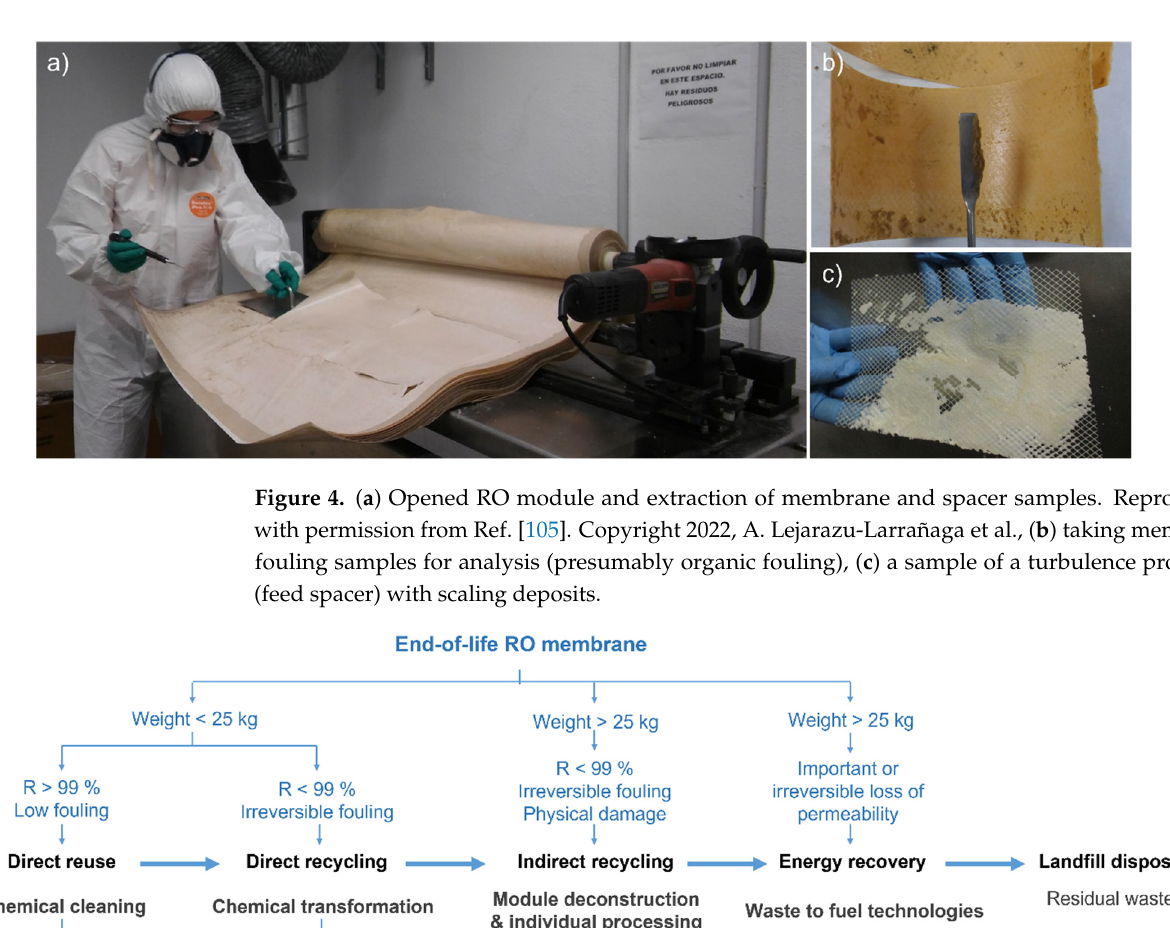
Figure 6. Schematic illustration of EoL RO membrane recovery for direct reuse as RO. PA, polyam- ide; PSF, polysulfone; PET, polyester. Those treatments resulted in some alteration of the RO salt rejection capacity ( R var- ied in the range between -29 % and 8 %), along with the enhancement of the membrane permeability (from ~3 L m − 2 h − 1 in new brand RO elements up to 261 L m − 2 h − 1 after the cleaning treatment). The reusability of RO membranes has been validated at a pilot scale in several applications of a lower water quality requirement, including desalination as “sacrifice” membranes (i.e., in the first or the last positions of a pressure tube, where the